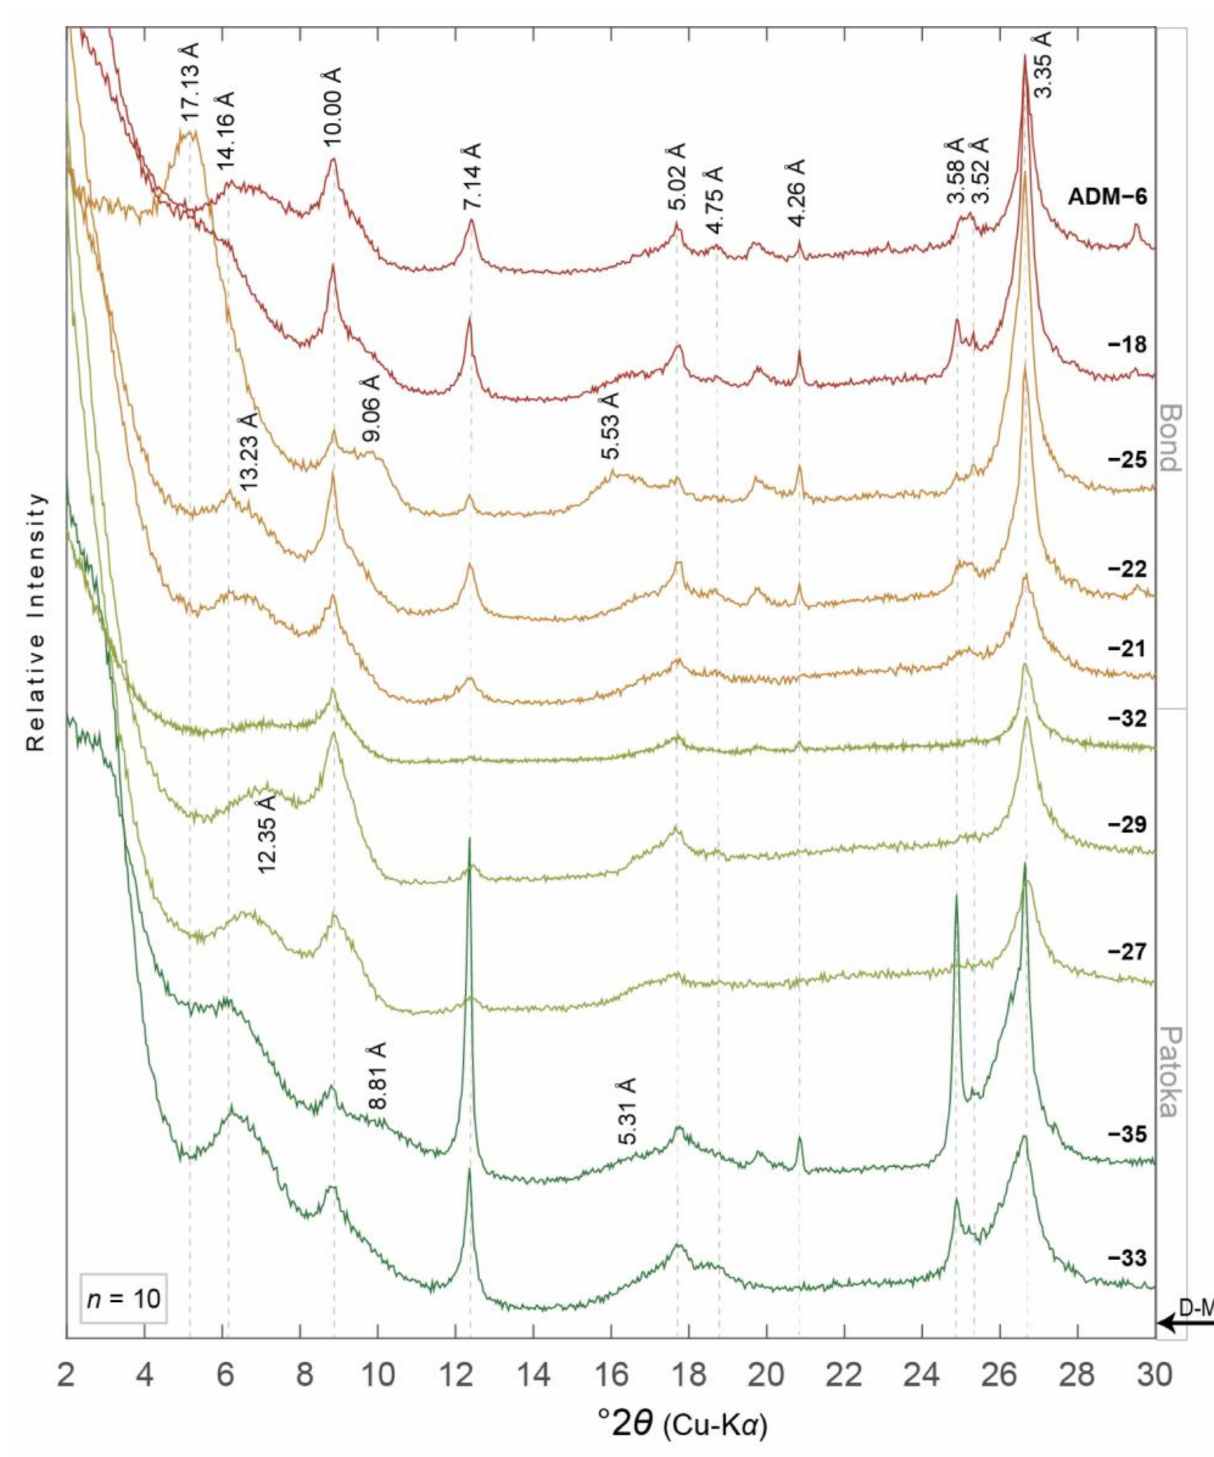
Figure 3. XRD patterns of ethylene glycol saturated oriented aggregates of the <2.0 µ m equivalent spherical diameter clay- sized fraction from paleosols in the Illinois State Geological Survey (ISGS) -Archer-Daniels-Midland, Borehole MMV-04B (ADM) core ( n = 10). Diffraction patterns are organized with respect to their relative stratigraphic position, i.e., ADM-33 and ADM-6 are stratigraphically the lowest and highest samples, respectively. D-spacing information for minerals discussed herein are noted vertically and in angstroms (Å). Diffraction patterns are colored to correspond with paleosol type, i.e., dark green = gleyed Vertisol (Pedotype C [43,44]), light green = gleyed calcic Vertisol (Pedotype D), ochre = gleyed vertic Calcisol (Pedotype E), and red = calcic Vertisol (Pedotype G). D-M = Desmoinesian–Missourian boundary. Core location noted in Figure 2. See Tables 1 and 2 for more